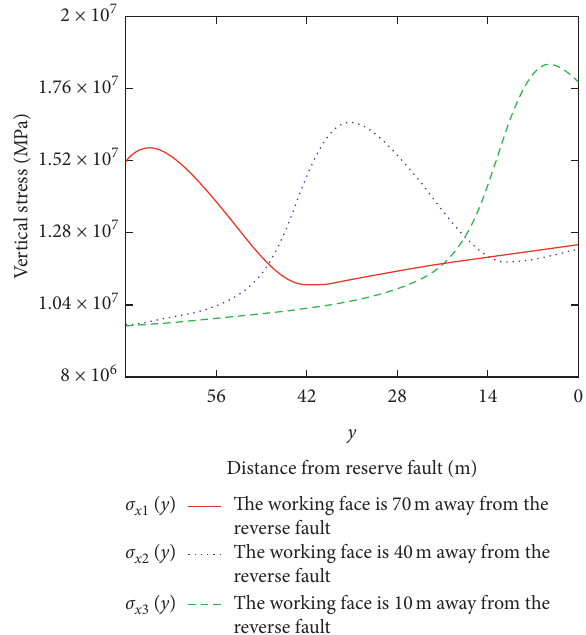
Figure 3: Vertical stress of coal body in different distance between working face and reverse